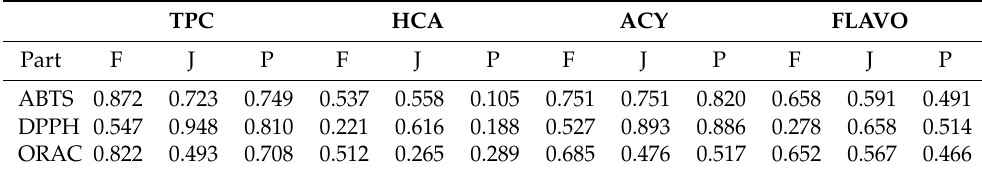
Table 4. Correlation coefficients ( R 2 ) between the content of different groups of polyphenolic com- pounds and the antioxidant capacity of 16 Sorbus fruit, juice, and pomace extracts. TPC HCA ACY FLAVO Part F J P F J P F J P F P ABTS 0.872 DPPH